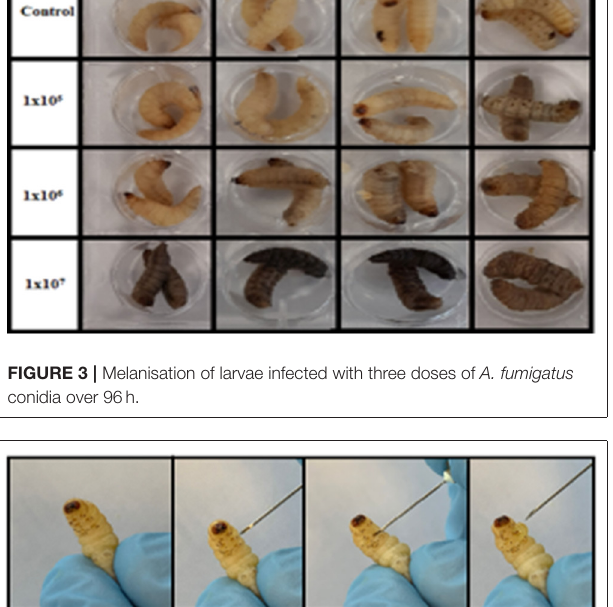
FIGURE 5 | Histological examination of G. mellonella larvae infected with Mucor circinelloides. Larvae were fixed in formalin 72h after infection, embedded in paraffin. Tissue sections were prepared at a thickness of 3.0 µ m and stained with Grocott silver stain to optimise visualisation of fungal elements. When larvae are incubated at 30 ◦ C (A) , germlings and hyphal elements are detected in higher abundance than when incubated at 37 ◦ C (B)